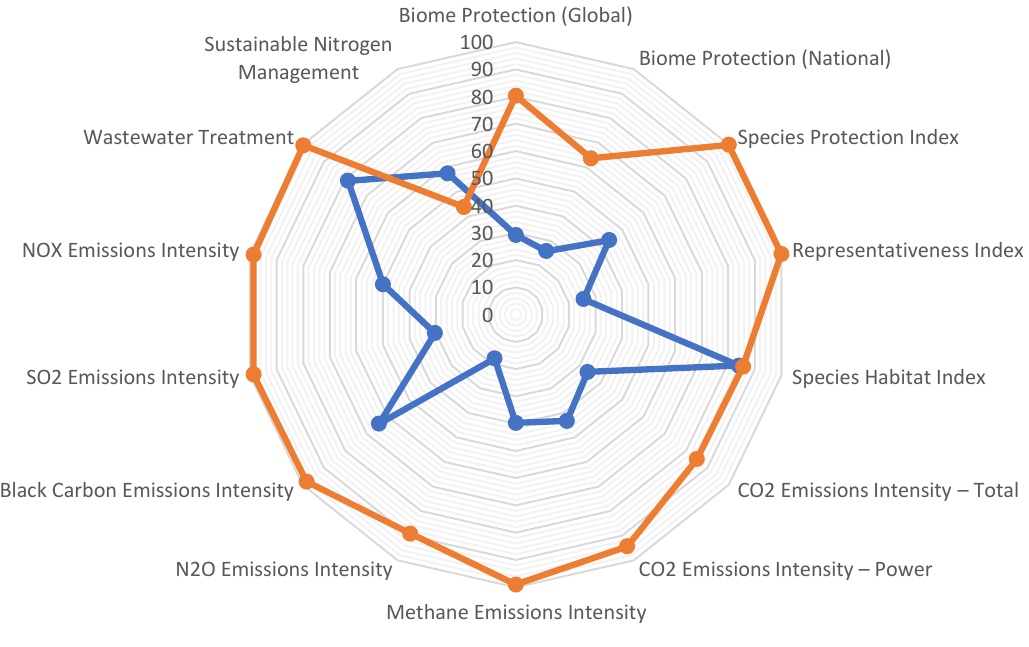
Source: Created by the authors on the basis of Environmental